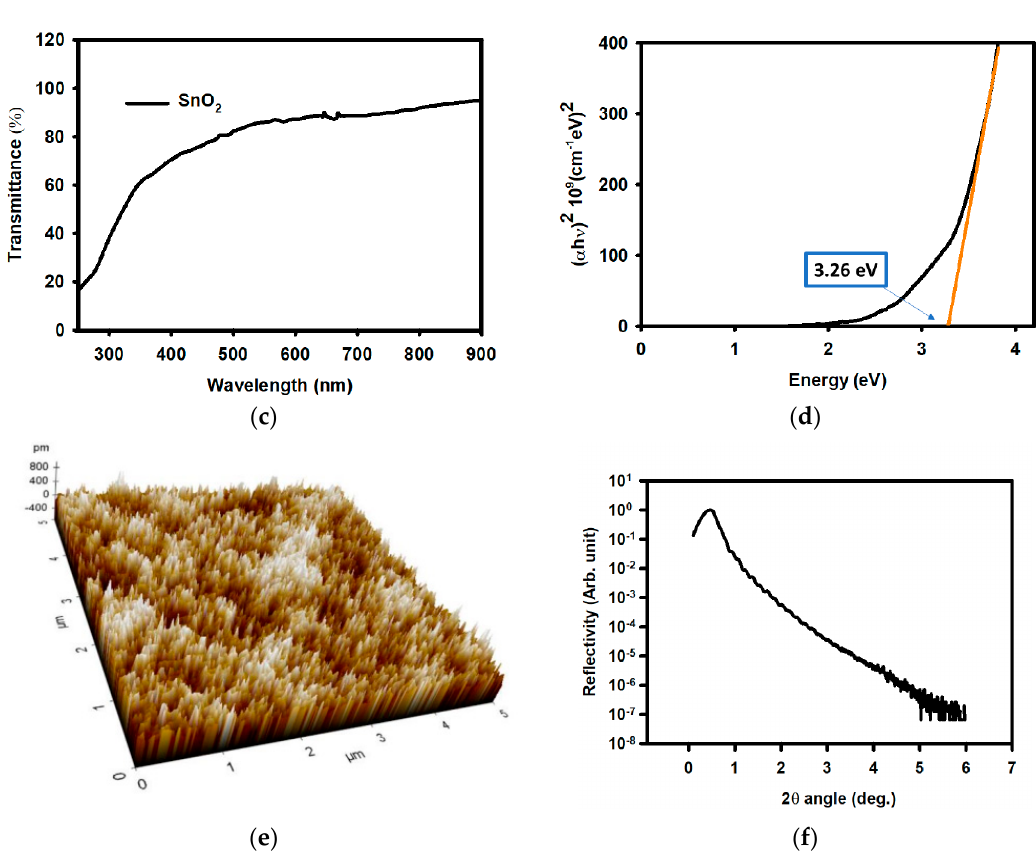
Figure 1. Physical properties of a-SnO x thin films annealed at 300 °C. ( a ) XRD pattern of a 40 nm thick SnO x . ( b ) High-resolution TEM image of SnO x used in a thin-film transistor (TFT) channel region; the inset shows the local fast Fourier transform (FFT) pattern. ( c ) Transmittance of a-SnO x thin film and ( d ) extraction of a-SnO x optical bandgap using a Tauc plot. The orange line is the extrapolation from the curve and the intersection with the abscissa axis gives the optical bandgap; the value is indicated in the blue box. ( e ) An AFM image of the a-SnO x surface. ( f ) The XRR measurement of the a-SnO x . In ( a ) and ( f ) arb. Stands for arbitrary.